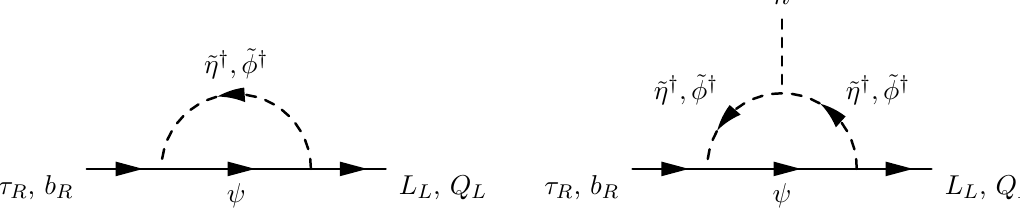
Figure 2. One-loop diagrams that generate effective τ -lepton and b -quark masses and effective Yukawa couplings after electroweak symmetry breaking in the Class 1